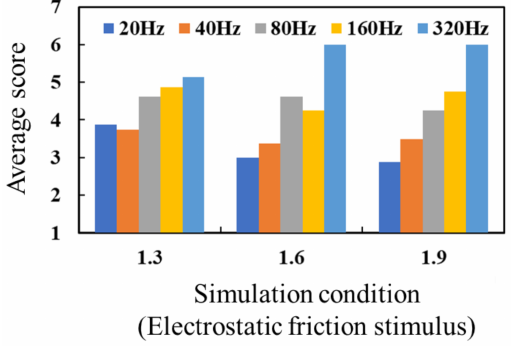
Figure 9. Average score of perceived friction via the electrostatic friction stimulus, with 1 meaning discontinuous friction and 7 meaning continuous